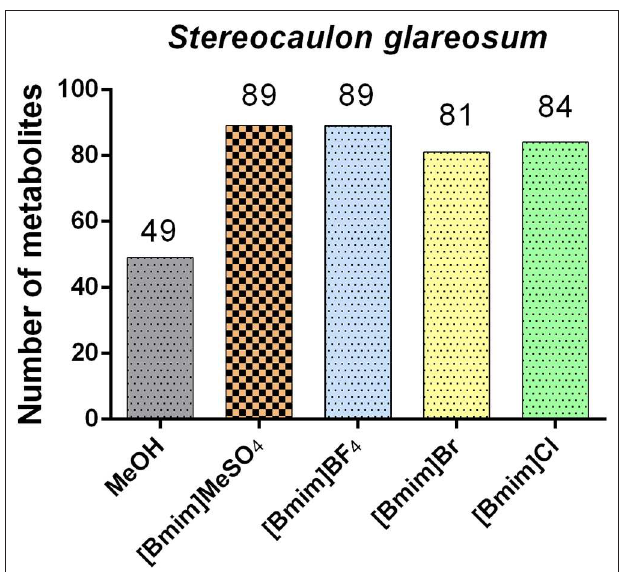
FIGURE 2 | Distribution of the number of lichen substances extracted by methanol and ionic liquids.